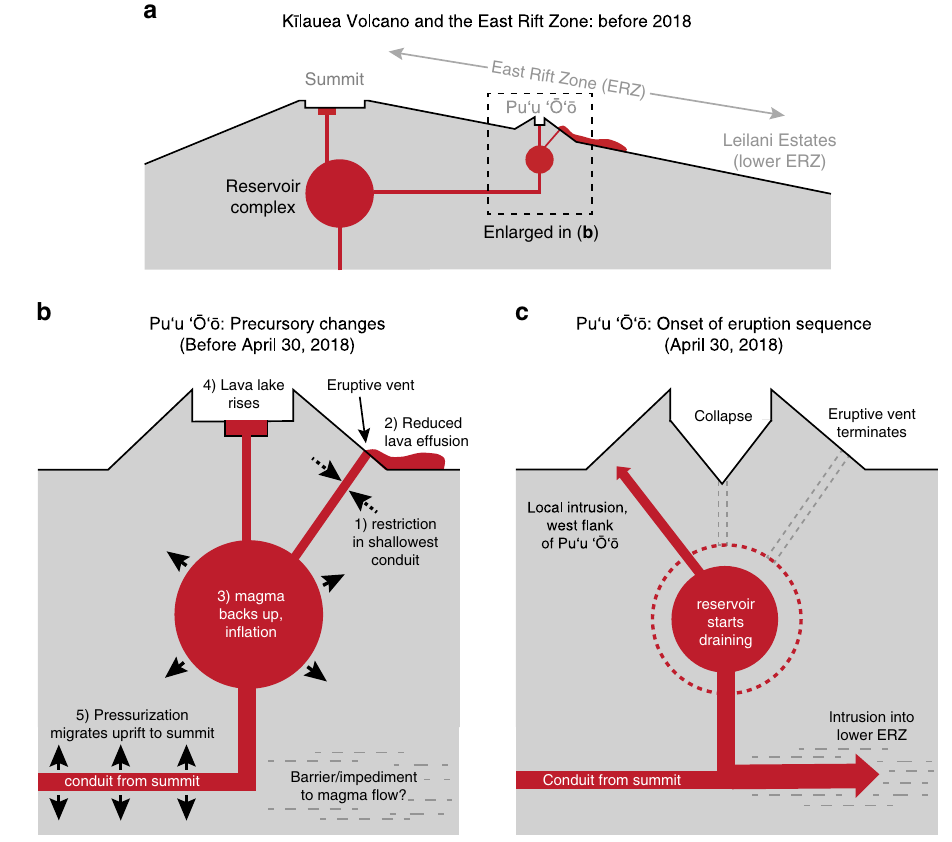
Fig. 6 Schematic showing the changes leading to the 2018 eruption. a Cross-section of K ī lauea from the summit down the East Rift Zone (ERZ), prior to 2018. Two simultaneous eruptions were occurring (summit and Pu ʻ u ʻ Ō ʻ ō ). b Proposed changes at Pu ʻ u ʻ Ō ʻ ō that led to the 2018 eruption. A restriction between the Pu ʻ u ʻ Ō ʻ ō magma reservoir and lava fl ow vent is hypothesized to have reduced lava fl ow effusion rate, causing magma to backup and accumulate in the magmatic system. This produced pressurization at Pu ʻ u ʻ Ō ʻ ō , and the summit via the ERZ magma conduit. c Onset of the 2018 eruption sequence at Pu ʻ u ʻ Ō ʻ ō . Overpressure produced a local intrusion on the west fl ank of Pu ʻ u ʻ Ō ʻ ō and initiated the larger injection of magma into the lower ERZ. Magma fl ow into LERZ triggered drainage of the Pu ʻ u ʻ Ō ʻ ō magma reservoir, causing crater fl oor collapse and termination of the lava fl ow vent. Table. 1 Priming processes and cascading events of the 2018 eruption of K ī